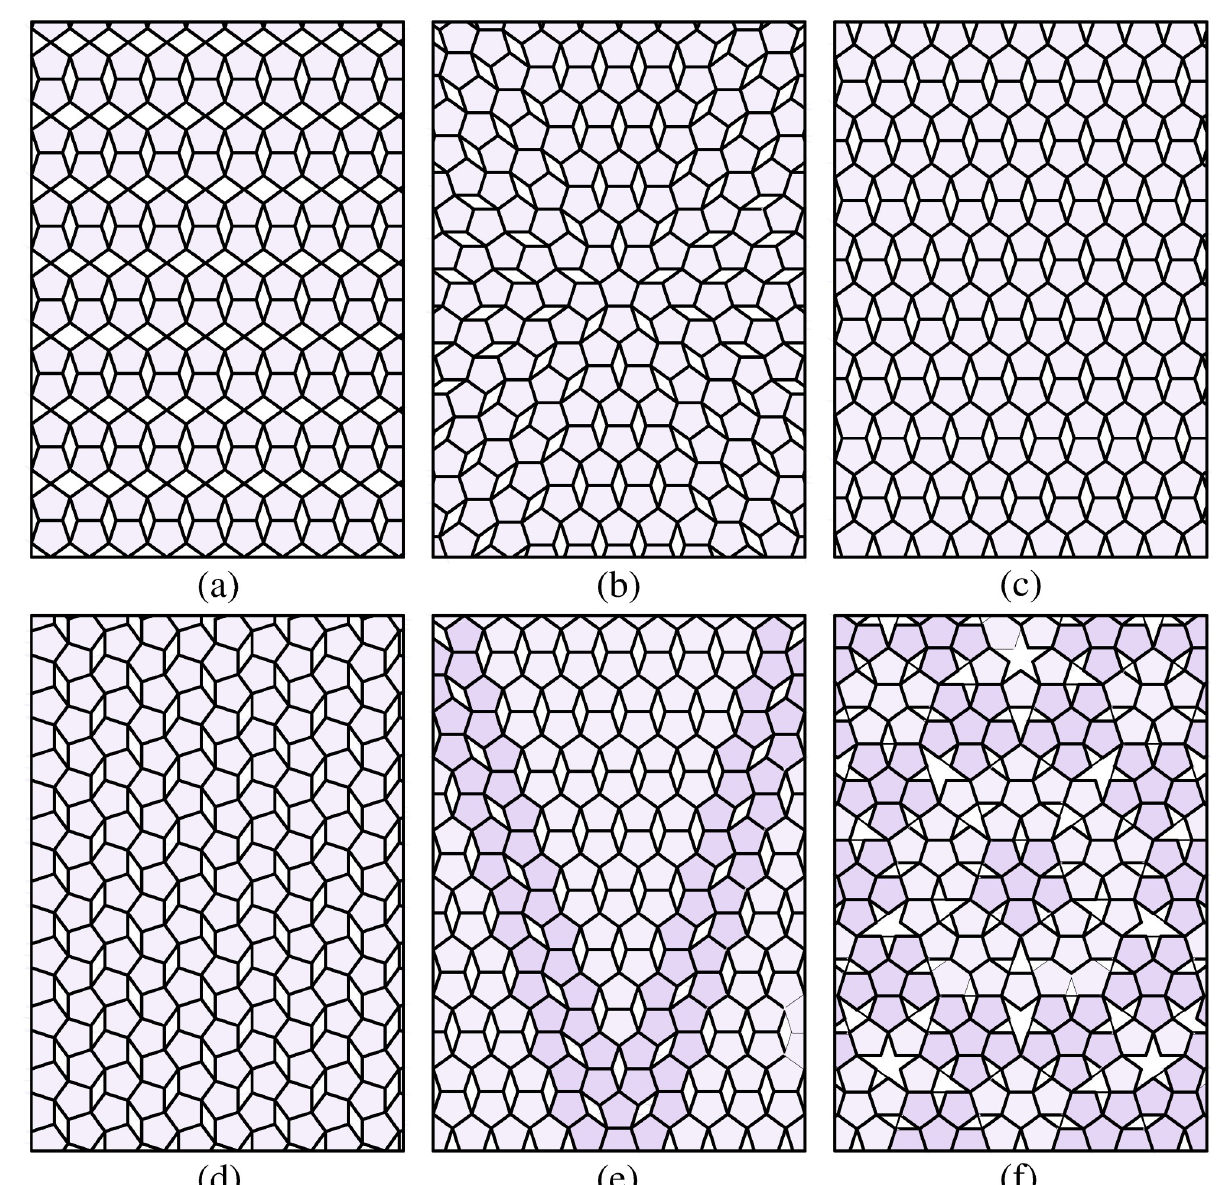
Fig 3. Patterns of the regular pentagon tiling. (a), (b) Two patterns of pentagon tiling from Durer including a five-fold nucleus that is expanded by multiple twins of five-fold symmetry (reconstructed from [6]). (c)-(e) Three patterns of pentagon tiling in art proposed by Caris (reconstructed from [7]). (f) Penrose tiling with five-fold symmetry generated by attaching multiple groups of a pentagon to the initial one (reconstructed from